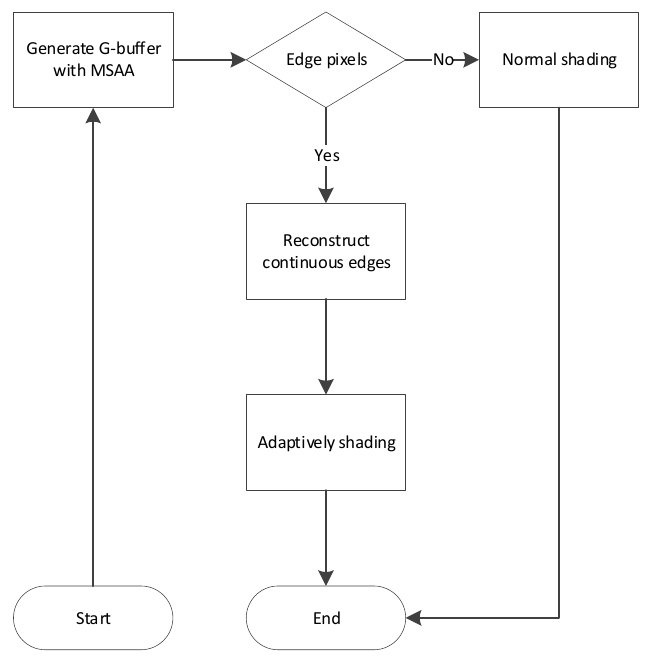
Figure 1. The process of the